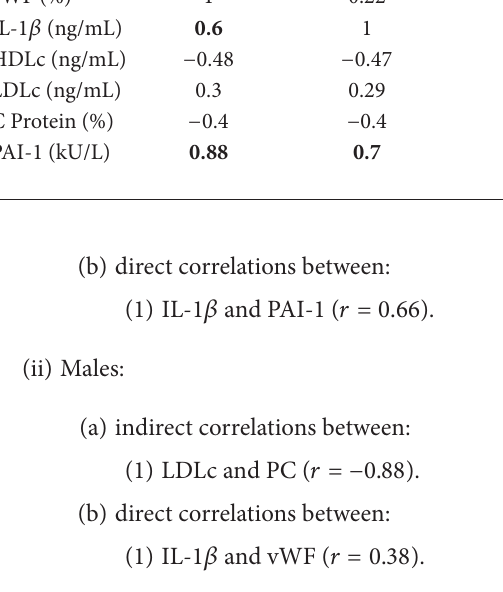
T 5: e correlation matrix between the monitored parameters in patients from DM correlation- ). 𝑟𝑟